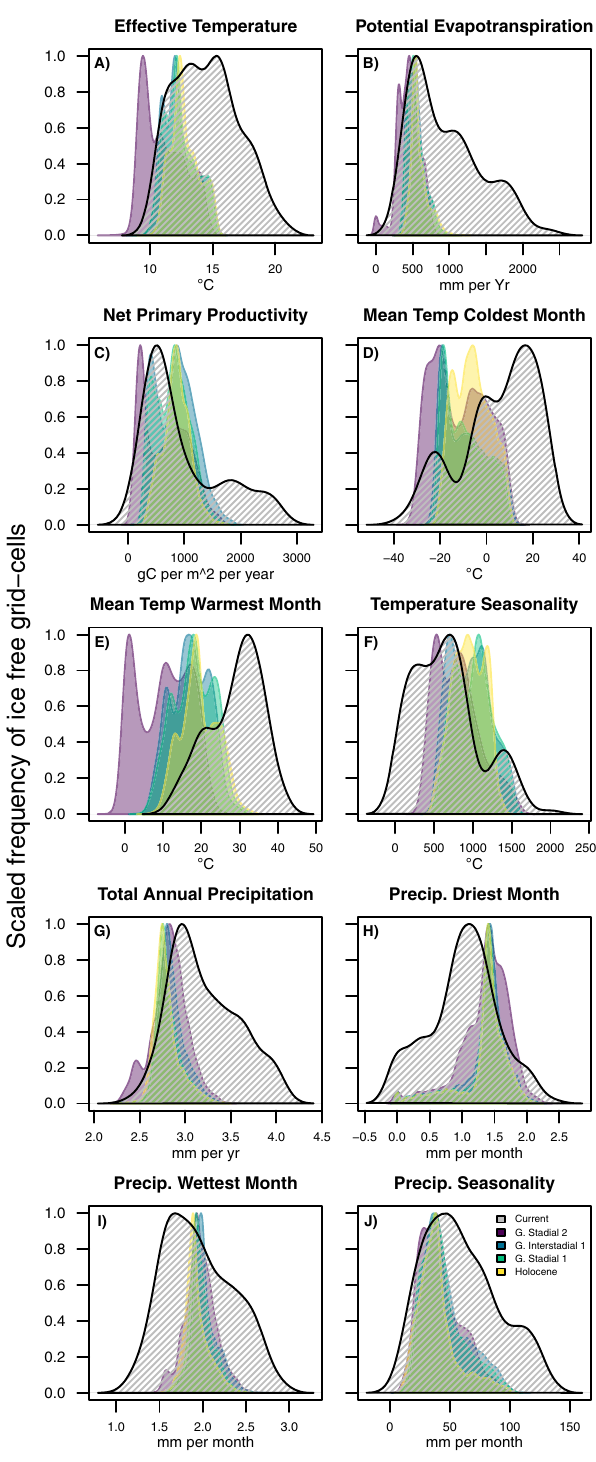
Fig. 2 | Distribution of climatic conditions today and selected periods during the Pleistocene-Holocene transition. Convergence between current climatic conditions (hashed density plots) and paleoclimatic conditions at four different periods (coloured density plots) for A Effective temperature, B Potential evapo- transpiration, C Net primary productivity, D Mean temperature of the coldest month, E Mean temperature warmest month, F Temperature seasonality, G Total annual precipitation, H Precipitation driest month, I Precipitation wettest month and J Precipitation seasonality. Paleoclimatic periods are Greenland Stadial 2, Greenland Interstadial 1, Greenland Stadial 1 and Early Holocene. Panels show the density plots for each evaluated variable (Variables are explained in Table